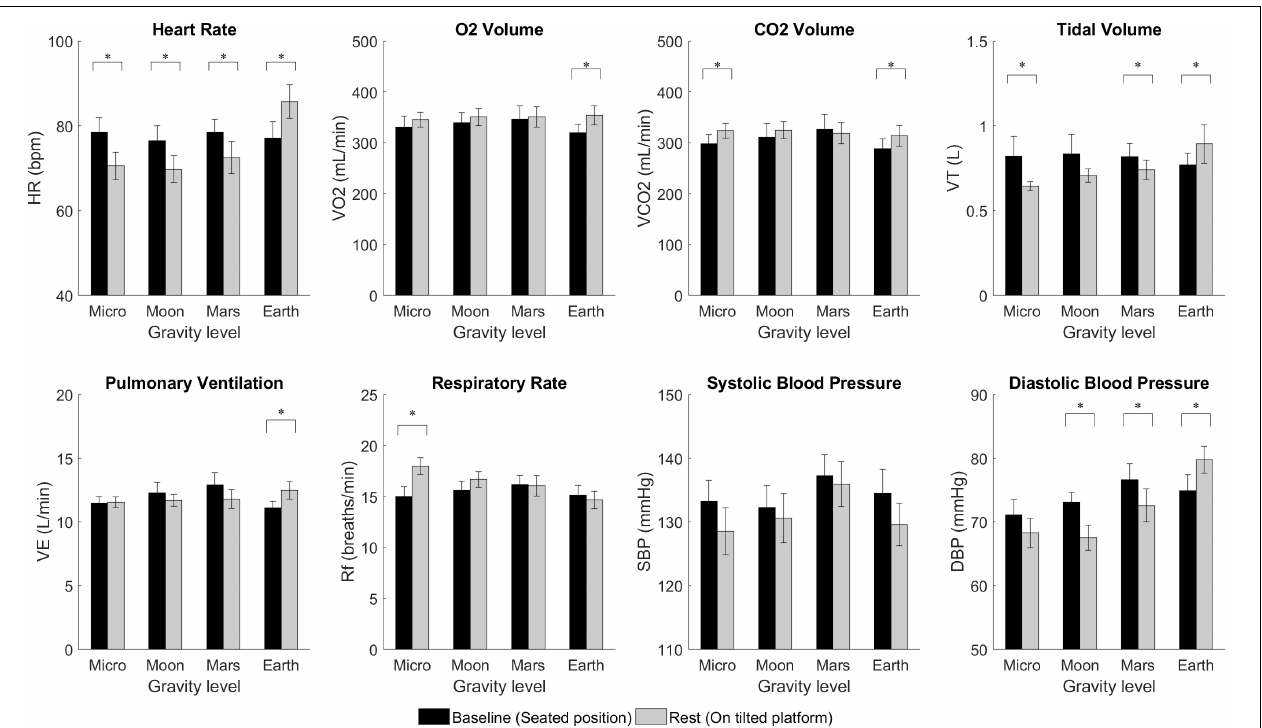
FIGURE 4 | Cardiopulmonary variables from 14 subjects (mean ± SE) at baseline (BL, seated) and at rest (on the platform) for the different altered-gravity environments (Microgravity − 6 ◦ HDT, Moon + 9.5 ◦ HUT, Mars + 22.3 ◦ HUT, Earth + 90 ◦ upright). The figure highlights significant differences between BL and Rest due to changes in posture (paired t -test ∗ significantly different at p < 0.05).